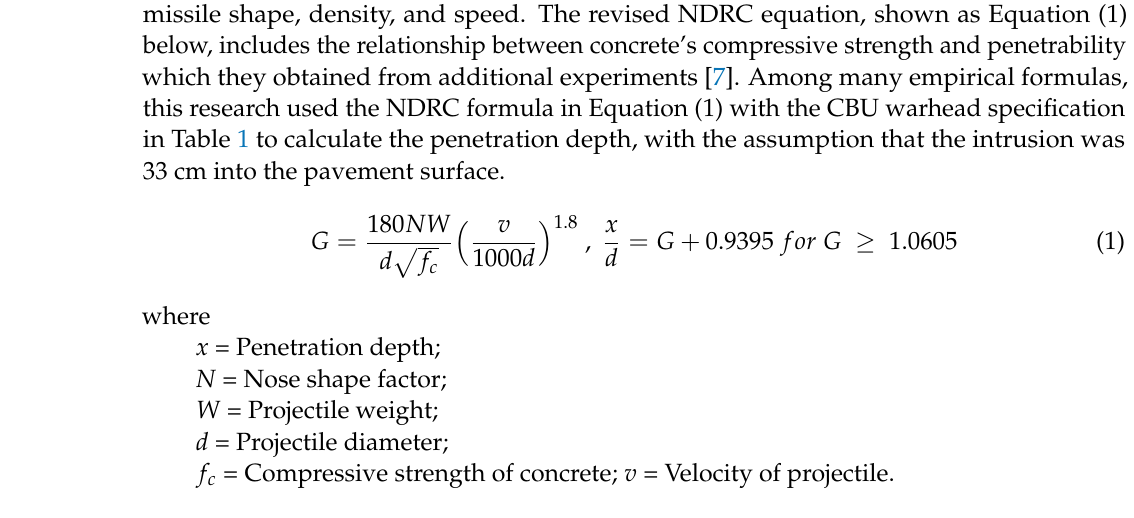
Table 1. Cluster bomb and concrete pavement